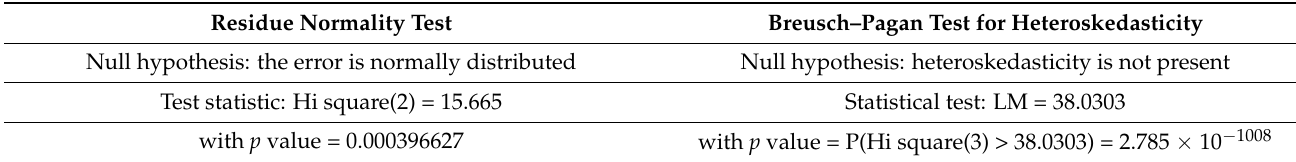
Table 7. Statistical tests to validate the American volatility matrix